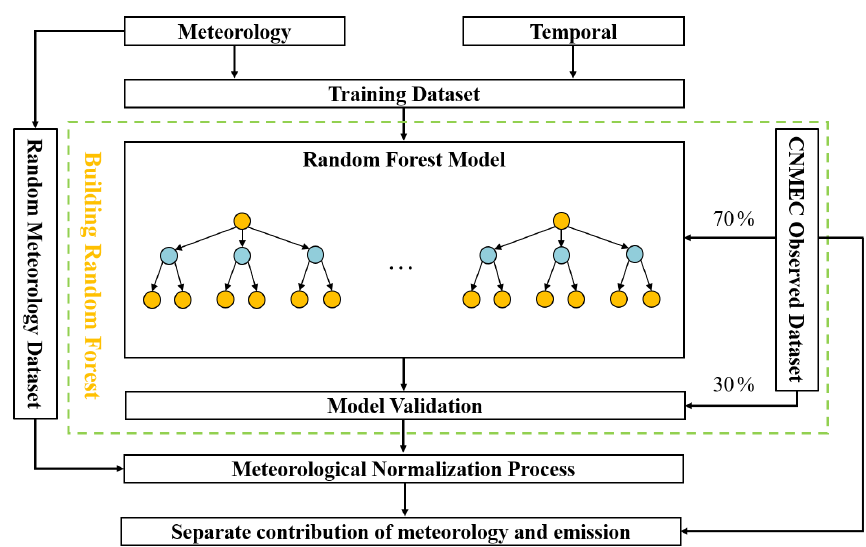
Figure 2. Flowchart for separation of meteorology and anthropological